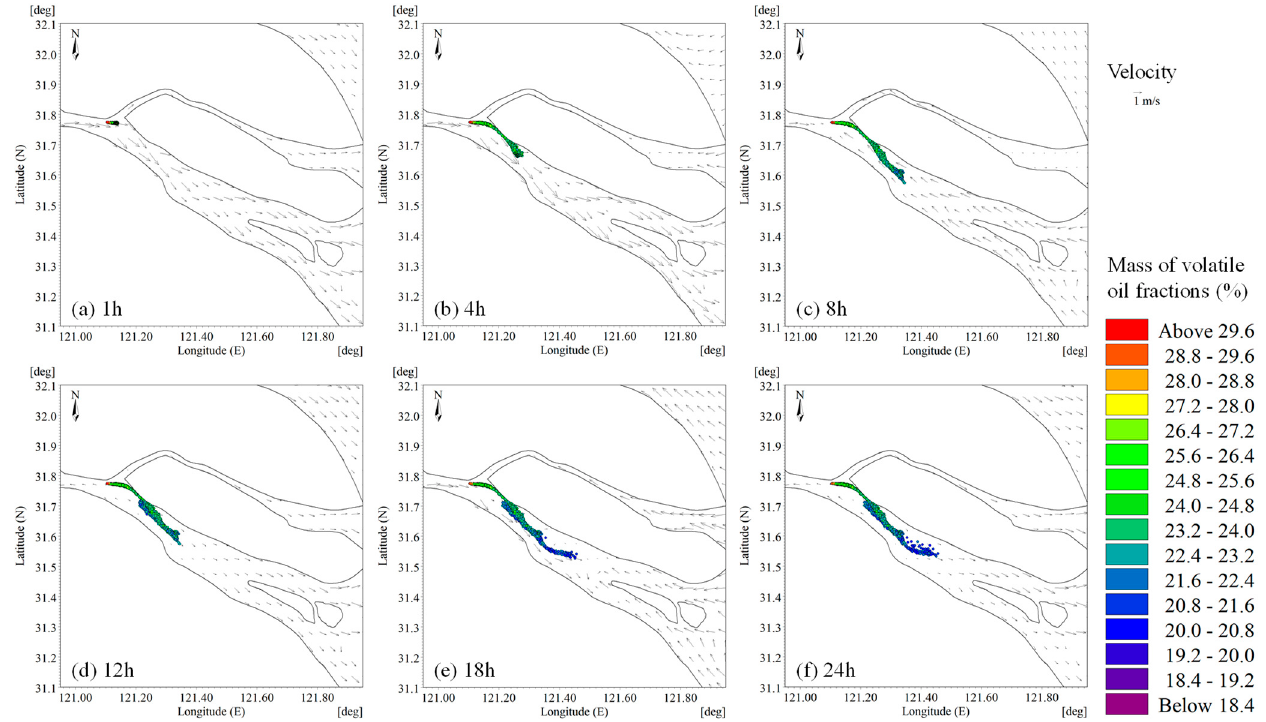
Figure 5. ( a – f ) Time evolution of oil particle track within 24 h after the accident which was at 16:45 on 30 December 2012 in the YRE. The color of circles indicates the mass of volatile oil fractions whose weight is below 160 g/mol, boiling point well below 300 ◦ C.